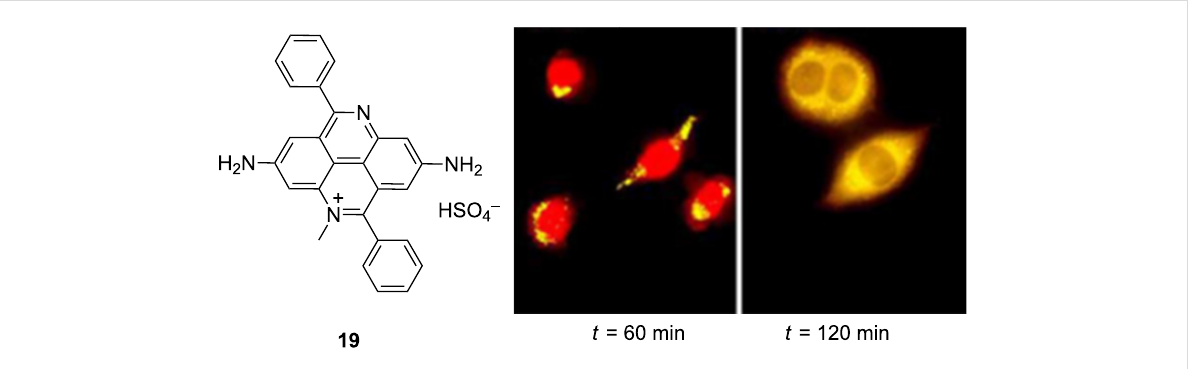
Figure 11: Structure of 4,9-DAP derivative 19 ; Rright: MIAPaCa-2 cells stained with 10 μ M 19 after 60 and 120 min incubation, respectively. Magnifi- cation 630×. Reproduced with permission from [95]. Copyright 2000 Royal Society of Chemistry.